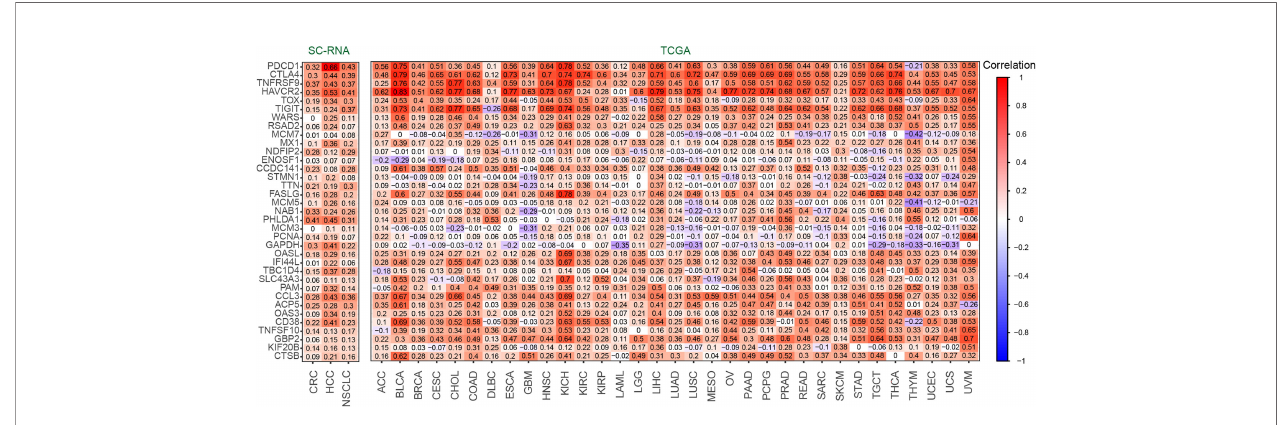
FIGURE 4 | The correlation coef fi cient between RGS1 and Candidate gene set of Tex cells in CD8+ T cells (left) and TCGA